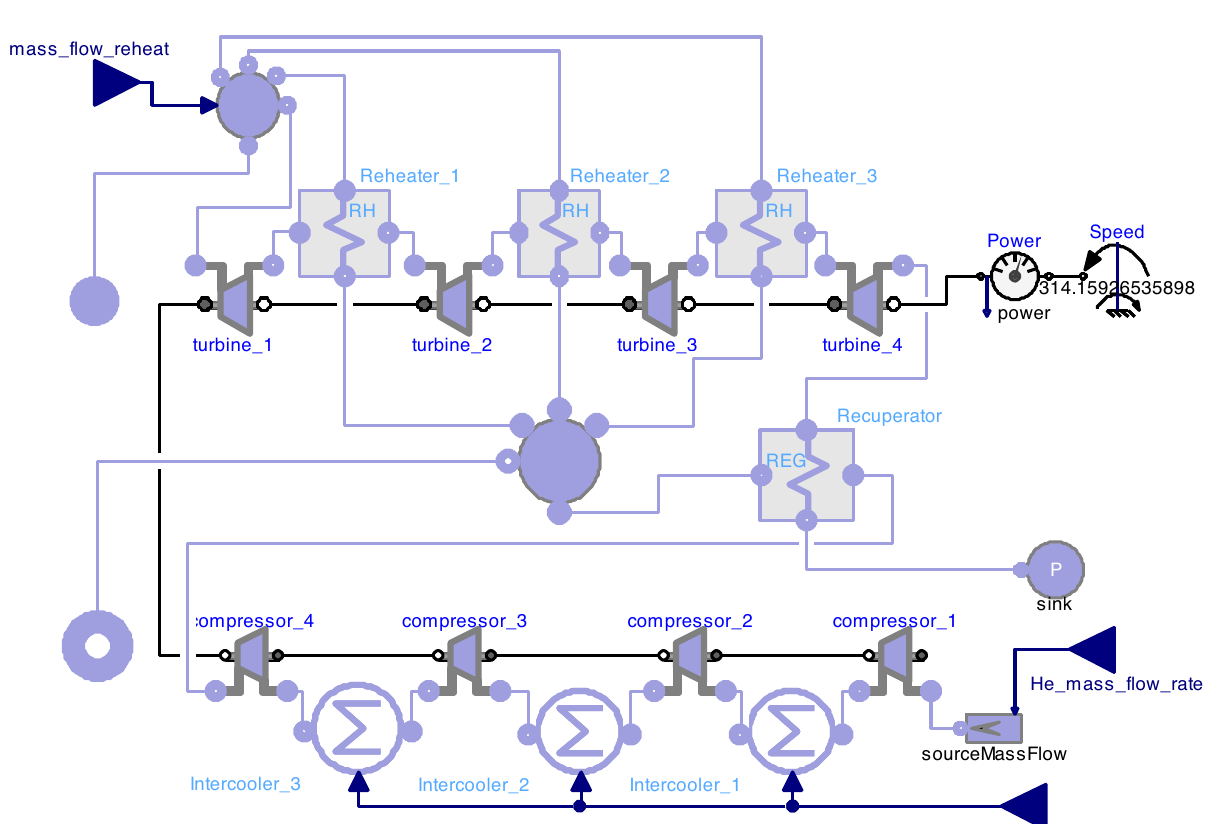
Fig. 9. Object-oriented Modelica model of the